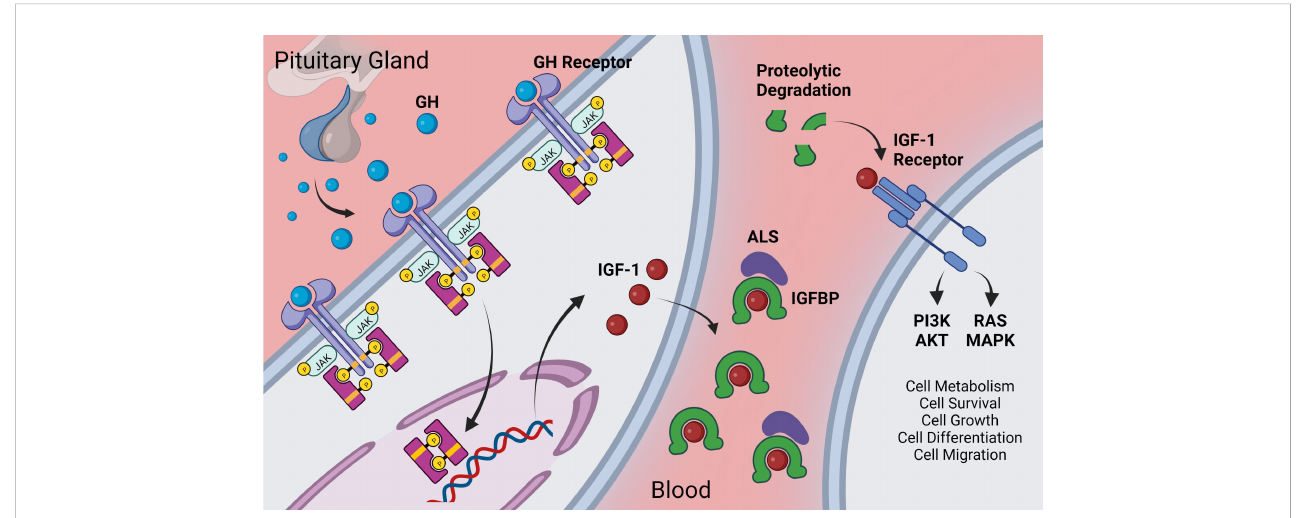
FIGURE 1 Overview of GH/IGF-1 signaling axis. Growth hormone is secreted from the anterior pituitary gland. It acts via the GH receptor on target cells via Janus kinase (JAK)-signal transducer and activator of transcription (STAT) – signaling to promote expression of various genes including IGF-1. Target cells include hepatocytes (for endocrine/circulating IGF-1) as well as other cells throughout the body that locally secrete IGF-1. Extracellular IGF-1 is bound to IGF-1 binding proteins (IGFBP) either in a two-part complex or in a three-part complex with the glycoprotein acid labile subunit (ALS). IGF-1 has higher af fi nity for IGFBPs than for the IGF-1 receptor, and IGF-1 is released from the IGFBP upon proteolytic cleavage of the IGFBP [for more on the complex role of IGFBPs, see (85)]. Freed IGF-1 interacts with the IGF-1 receptor where it signals, largely through the PI3K/AKT and the RAS/MAPK cascades to regulate many pro-survival cellular pathways. Created with